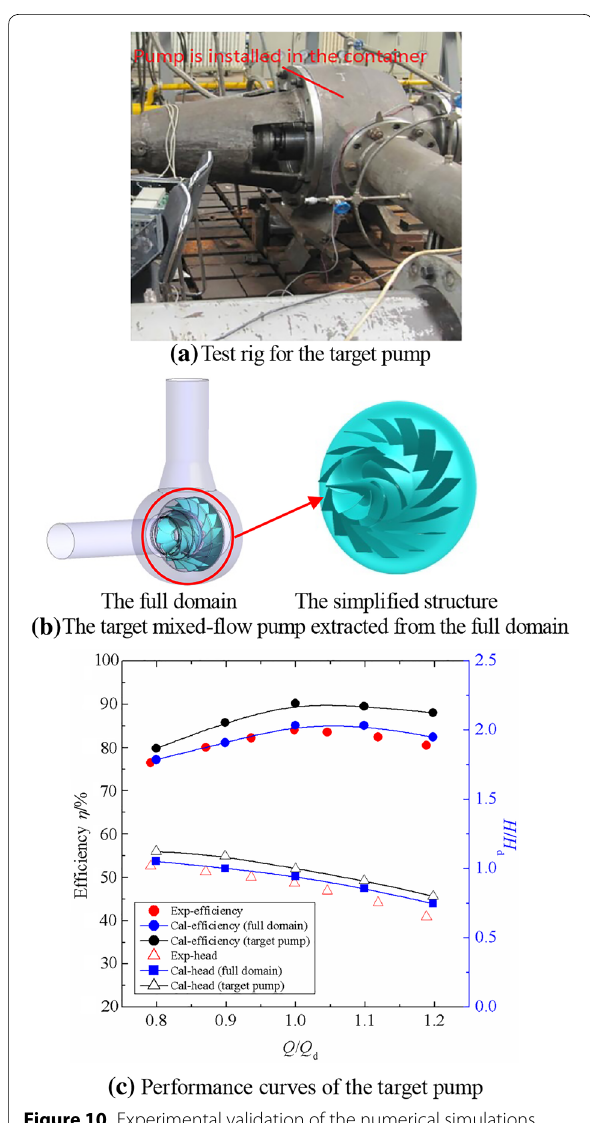
Figure 10 Experimental validation of the numerical